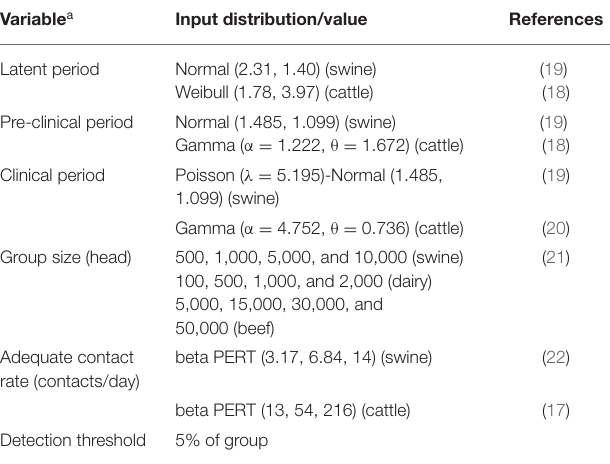
TABLE 1 | Input parameters used in the FMD spread model in swine, dairy and beef cattle